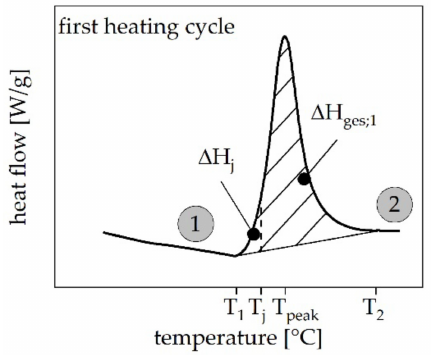
Figure 3. General route of a DSC measurement in the first heating cycle with characteristic parameters for the